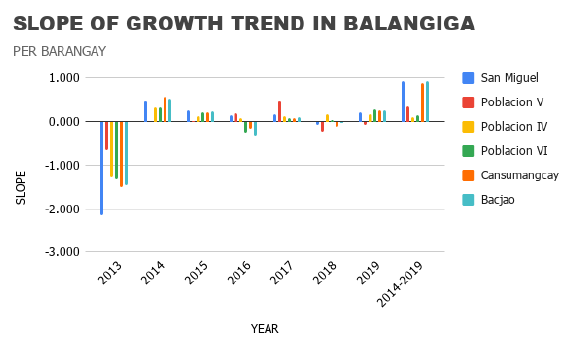
Figure 11. Bar graph showing the comparison of slopes per barangay in